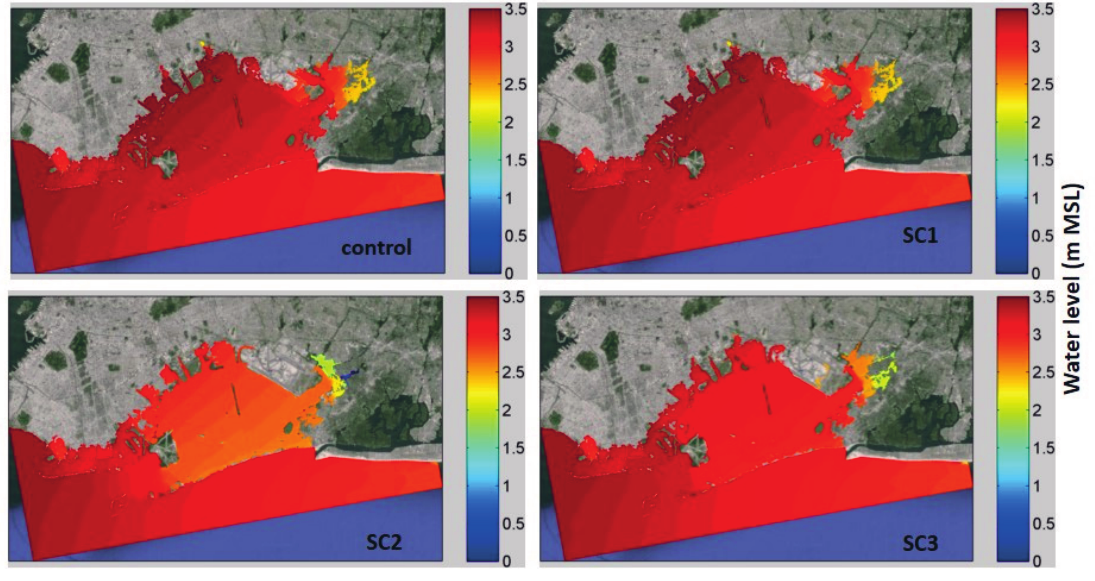
Figure 6. Results for Hurricane Sandy (peak water levels) in map view for control run and Scenarios 1, 2 and 3. Water levels are shown relative to local mean sea level (MSL) at